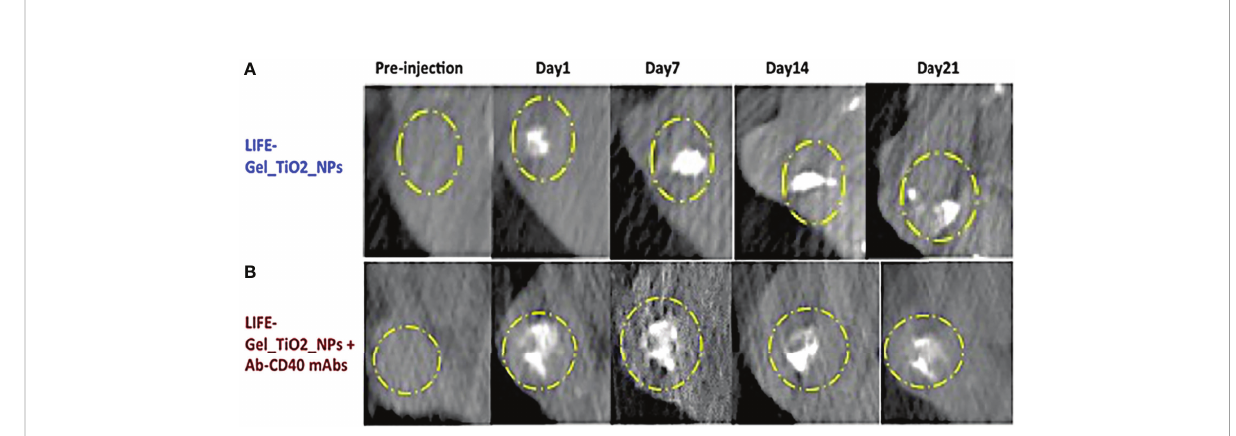
FIGURE 3 CT images showing contrast from LIFE biomaterials injected in mice pancreatic tumors. (A) The LIFE biomaterial formulation was prepared using a mixture of 4% (w/v) (v = 50 uL) alginate biomaterial solution added to a 1% (w/v) (v = 50 uL) chitosan solution in a 1:1 ratio. 10 uL volume titanium dioxide (TiO2) nanoparticles was added to the polymer mixture. (B) The LIFE biomaterial formulation was prepared as in (A) plus monoclonal antibody (mAb), Ab-CD40 (v = 2.3uL/injection), Study in mice was conducted to assess CT image contrast for up to 21-days.